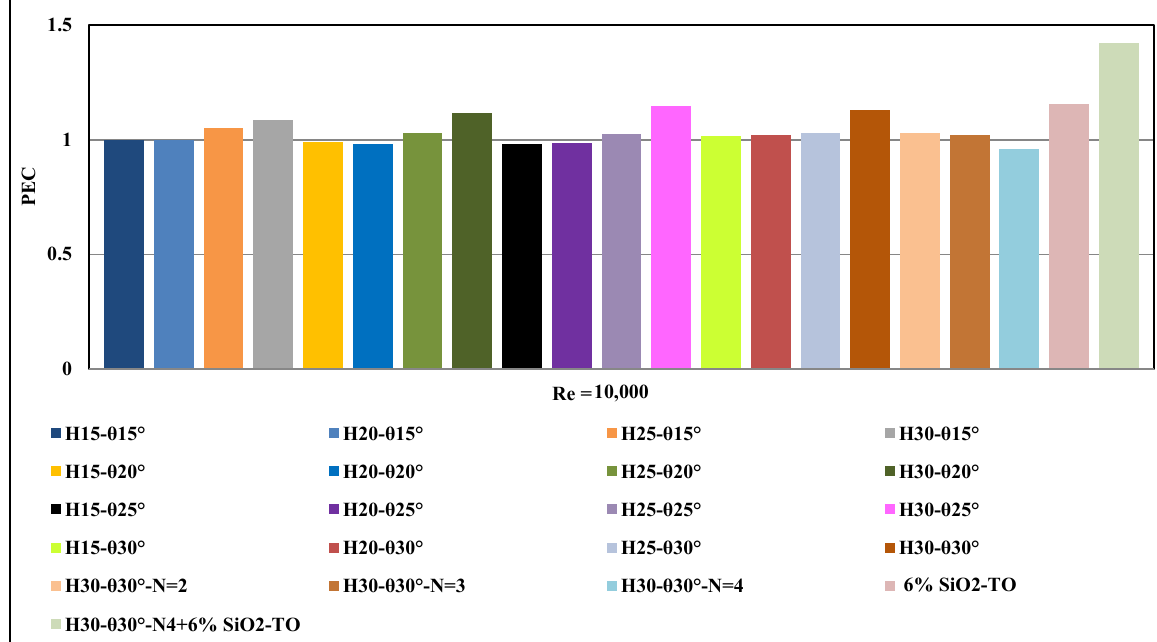
Figure 16. Effect of configuration changes on the performance evaluation c riterion (